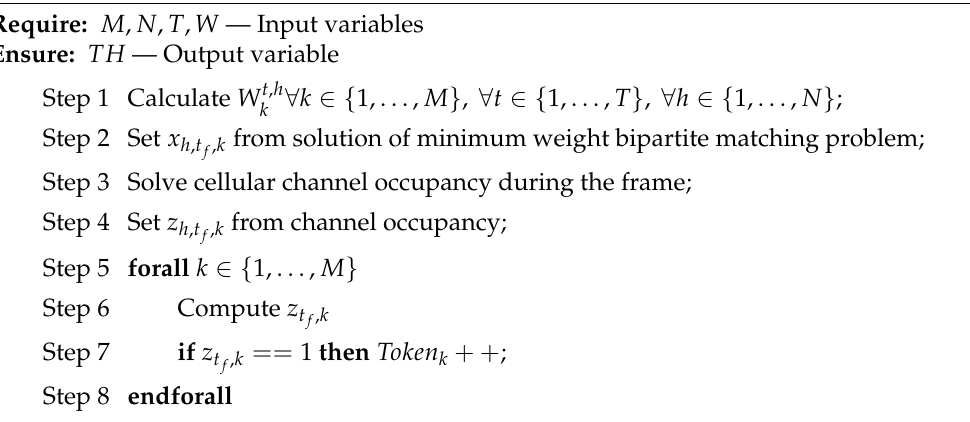
Algorithm 1 Scheduling algorithm on frame